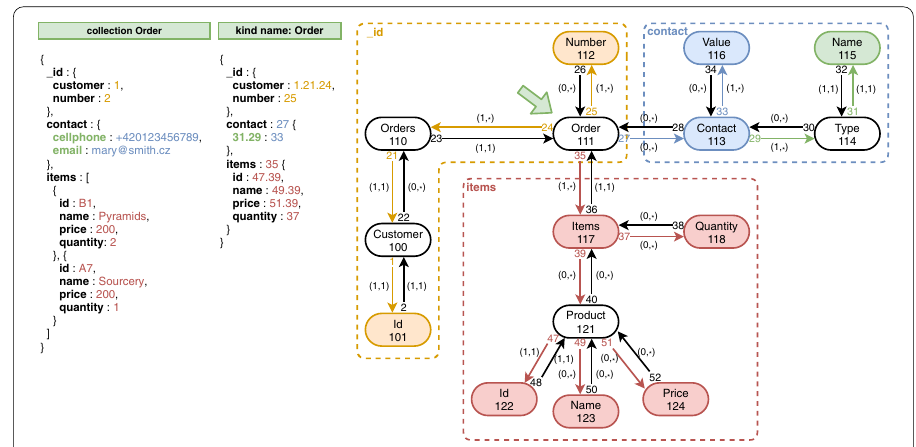
Fig. 6 Collection Order , an access path for kind Order , and the corresponding part of schema category